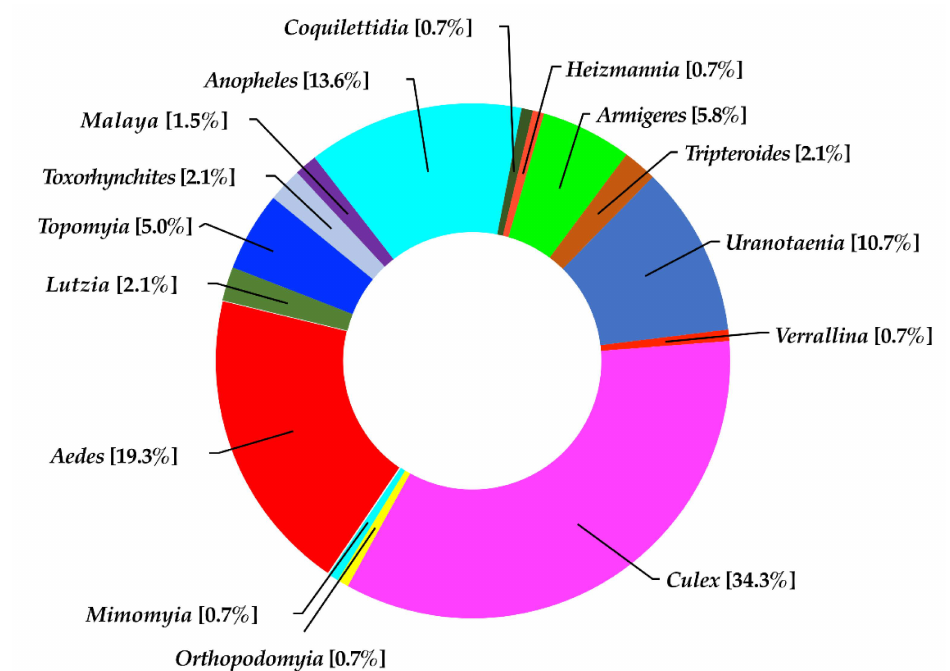
Figure 2. Community structure of mosquitoes in Doi Inthanon National Park.